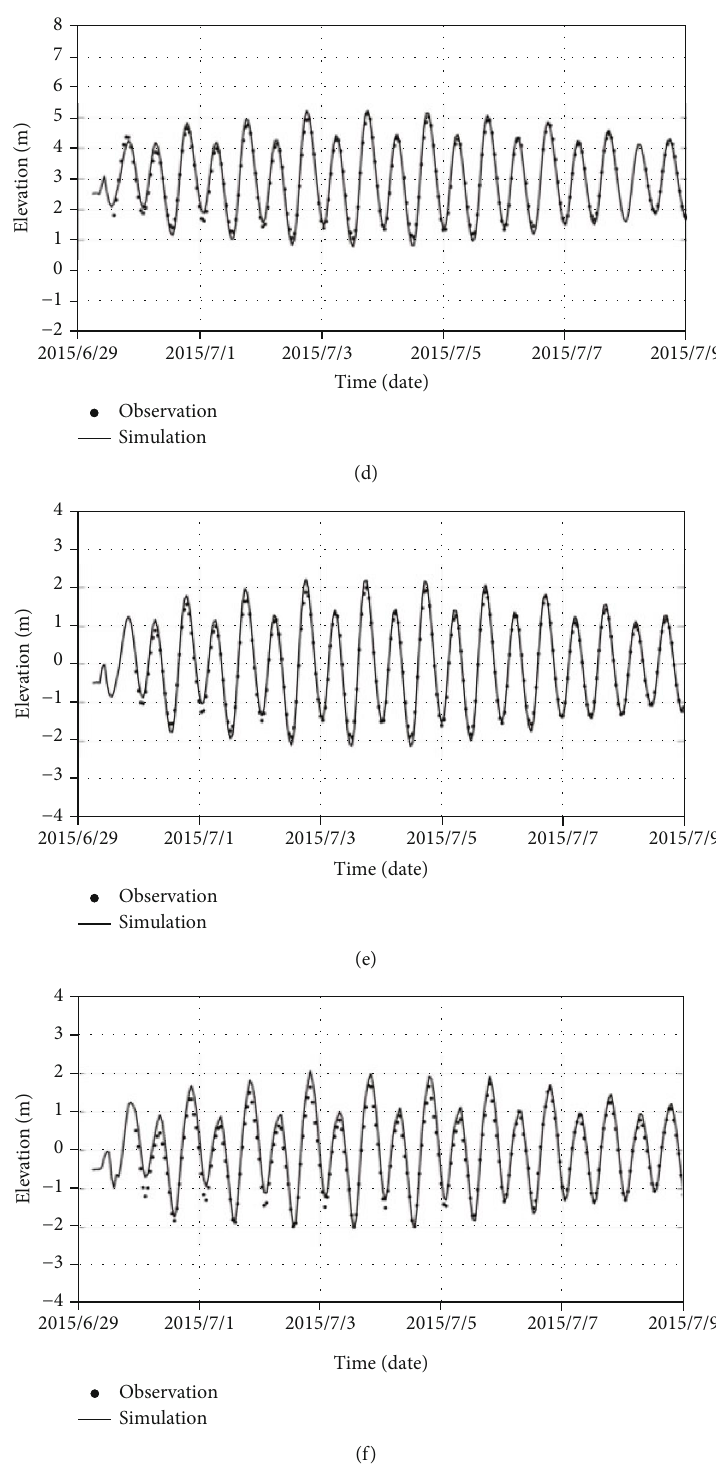
Figure 6: Comparison of simulated and observed tidal levels in Hangzhou Bay. (a) Yangshan Port. (b) Beilun. (c) Daishan. (d) Lvhua. (e) Shengshan. (f)